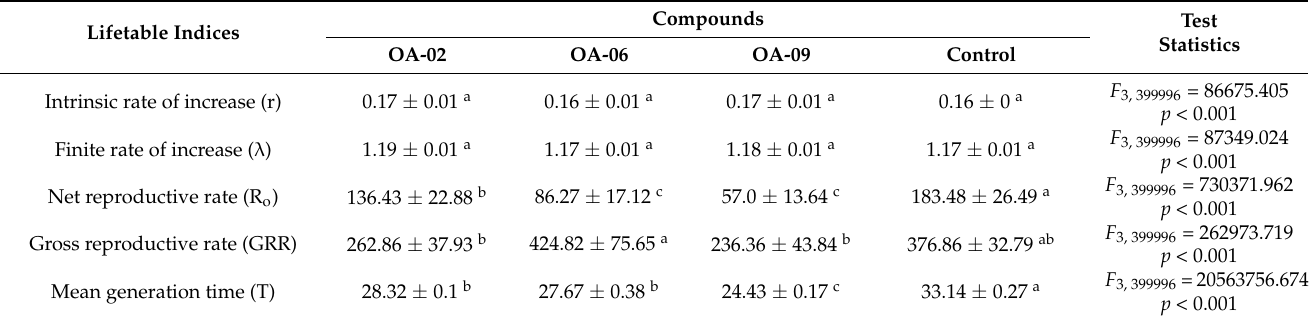
Table 6. Lifetable parameters of Helicoverpa armigera populations exposed to OA-02, OA-06 and OA-09